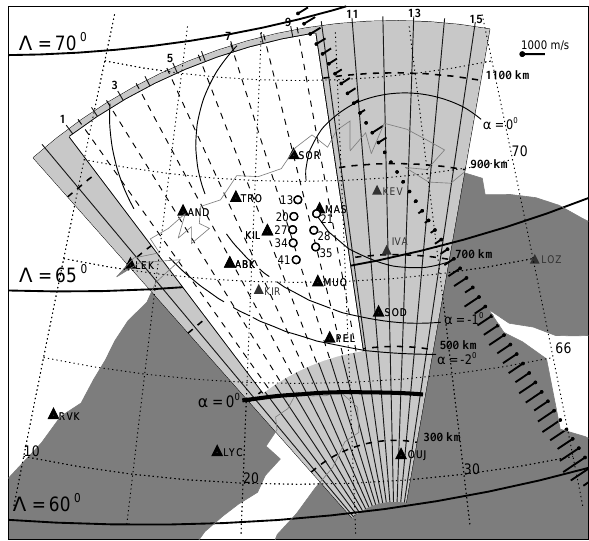
Fig. 1. The experimental setup in Northern Scandinavia show- ing the near ( r< 1200km) fields of view of the CUTLASS (grey) and STARE (white) Finland radars. The nominal directions of the CUTLASS (STARE) beams 0–15 (1–8) are indicated by the solid (dashed) straight lines. Also shown are slant range marks (dashed circular curves) and PACE lines of equal magnetic latitudes 3 = 60 ◦ , 65 ◦ , and 70 ◦ (solid black curves). The black thin curves α =− 2 ◦ , − 1 ◦ , 0 ◦ represent the geometrical off-perpendicular (as- pect) angle lines at 110km. The heavy black curve α = 0 ◦ is the perfect aspect angle line at 110km, assuming a model electron den- sity profile and a radar frequency of 12 MHz. The location (with the three-letter abbreviation) of the stations of the IMAGE and SAM- NET magnetometer networks close to the radars’ FoV is shown by triangles. The open circles (with digits nearby showing the beam number) represent the easternmost IRIS beams (at 100km) close to the meridional direction of interest. The DMSP pass (F13: 14:18– 14:21UT) with the measured perpendicular ion velocities is indi- cated by black vectors. The scale for the ion velocities is shown in the top right corner of the